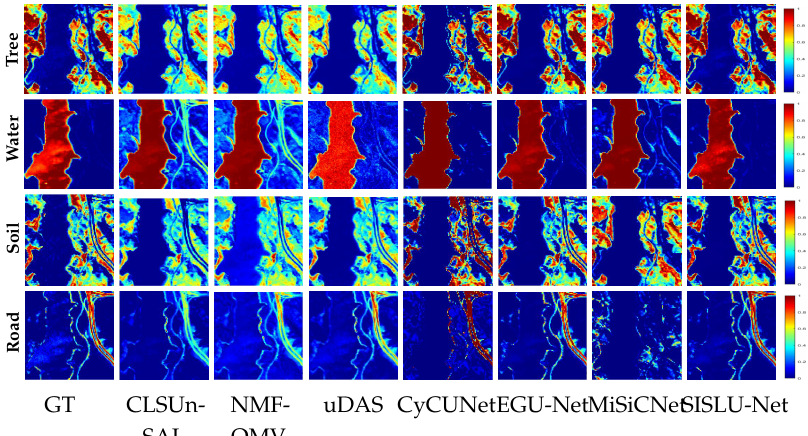
Figure 11. Estimated abundances by all competing methods on the Jasper Ridge